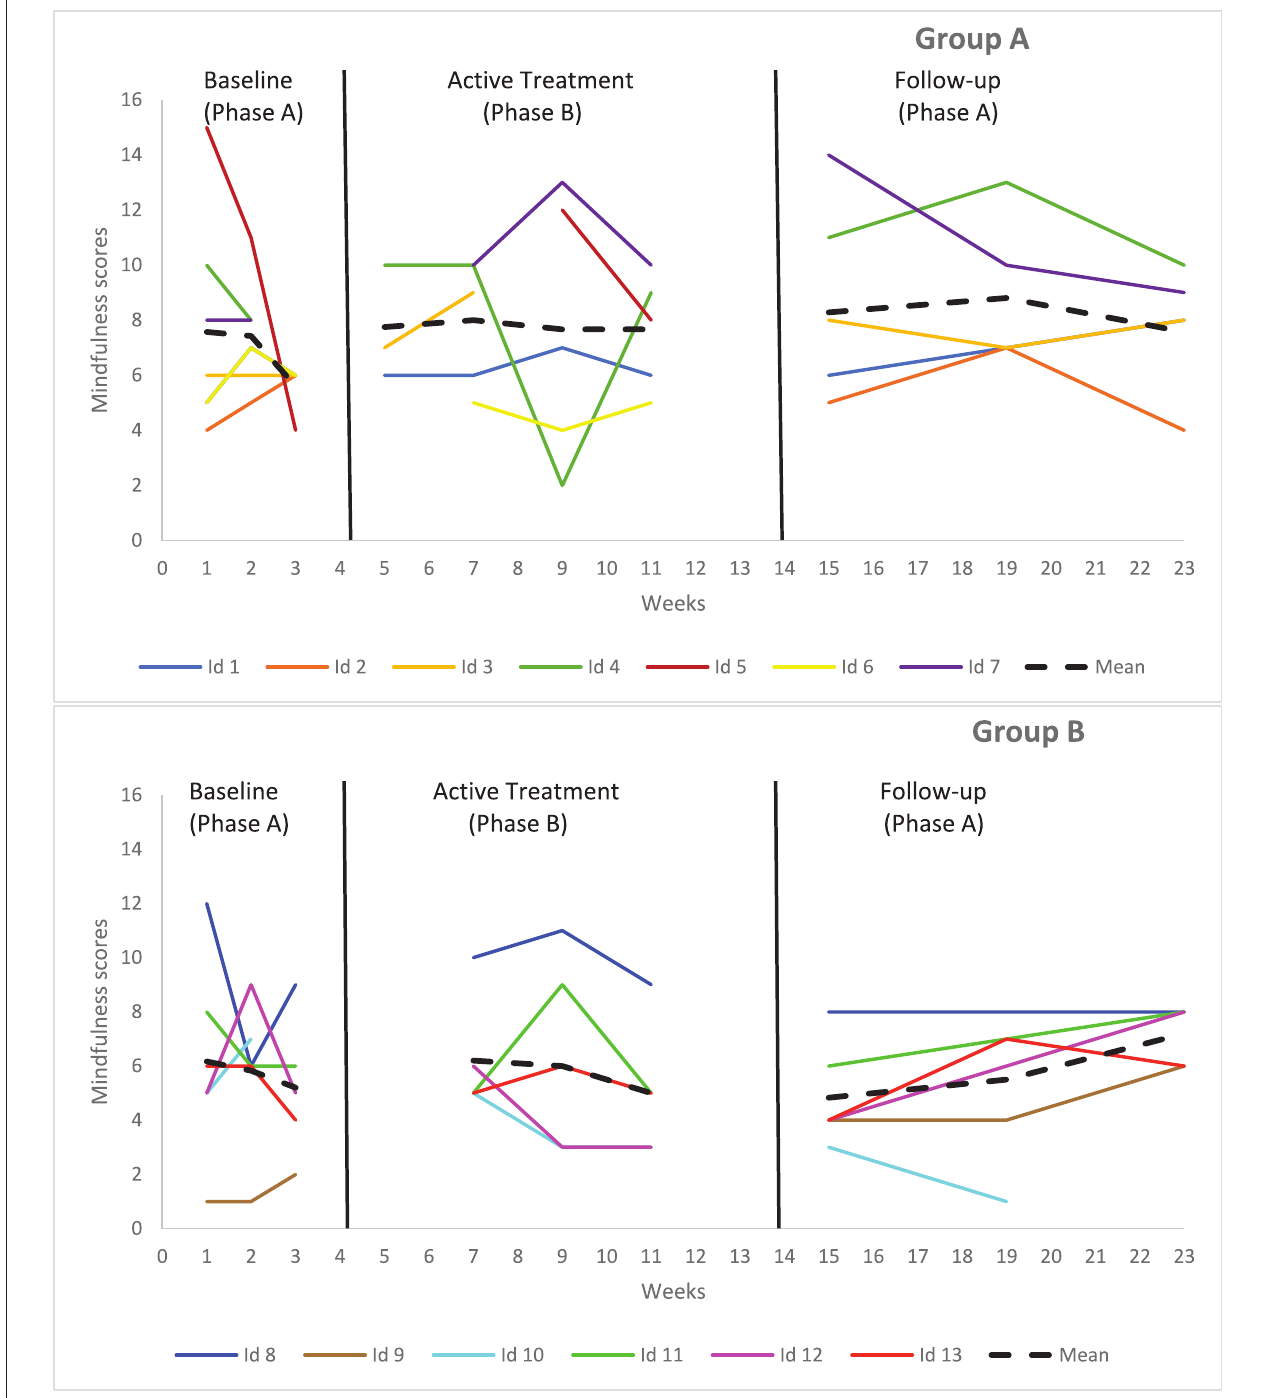
FIGURE 5 | Graphical display of baseline level and changes in level between consecutive phases in mindfulness for self-reported data.